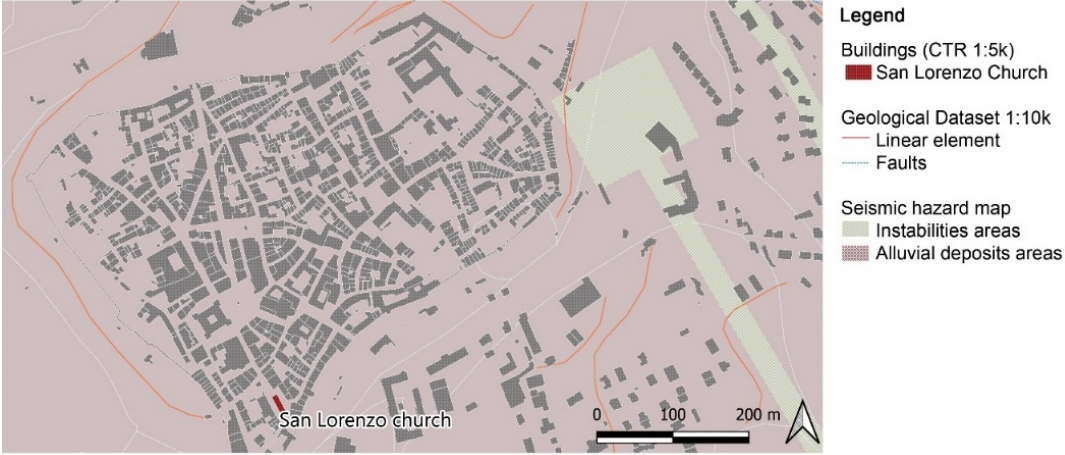
Figure 4. LoD 0 of the San Lorenzo Church and its context (in QGIS software).